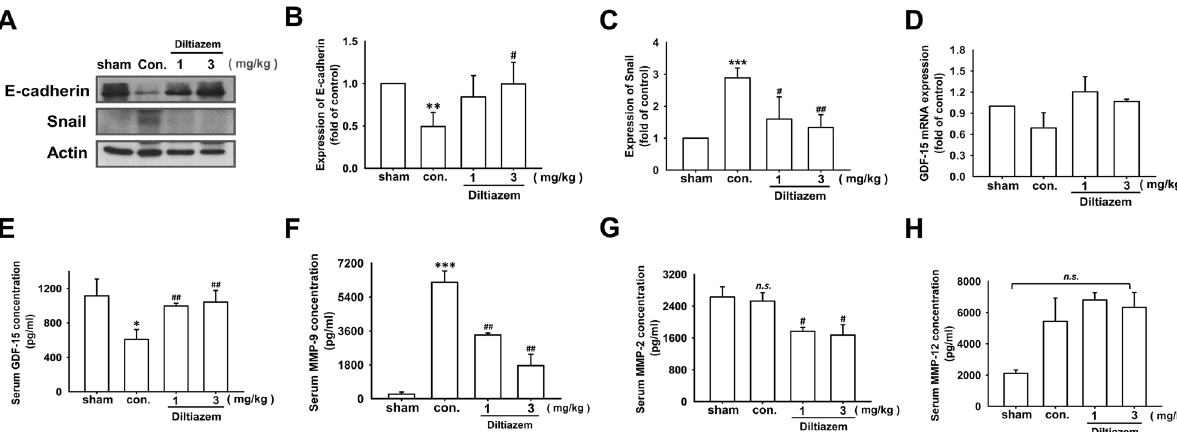
Fig. 9 Diltiazem in fl uences EMT markers, GDF-15 and MMPs expressions in vivo. A – D The protein expression of epithelial marker E- cadherin, mesenchymal marker Snail, and the mRNA expression of GDF-15 were examined by using homogenized lung tissues. Graphs showed mean ± S.D. of at least three independent experiments. E – H The expression of serum GDF-15, MMP-9, MMP-2, and MMP-12 were measured by ELISA. Graphs showed mean ± S.E.M. of at least four independent experiments. p value was calculated using Student ’ s t test. * p < 0.05; ** p < 0.01; *** p < 0.001 compared to sham group. # p < 0.05; ## p < 0.01 compared to control